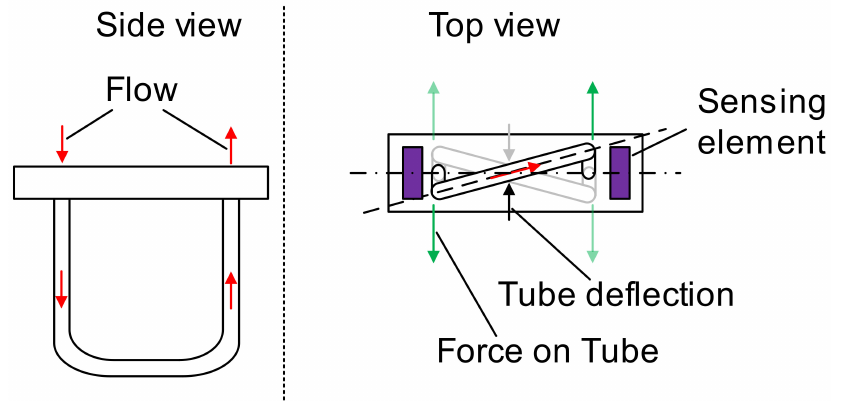
Figure 5. Coriolis mass flow meter in different phases of deflection, red arrows show flow direction, green arrows show the force on the tube due to the influence of coriolis acceleration, sensing elements measure twist of tube.